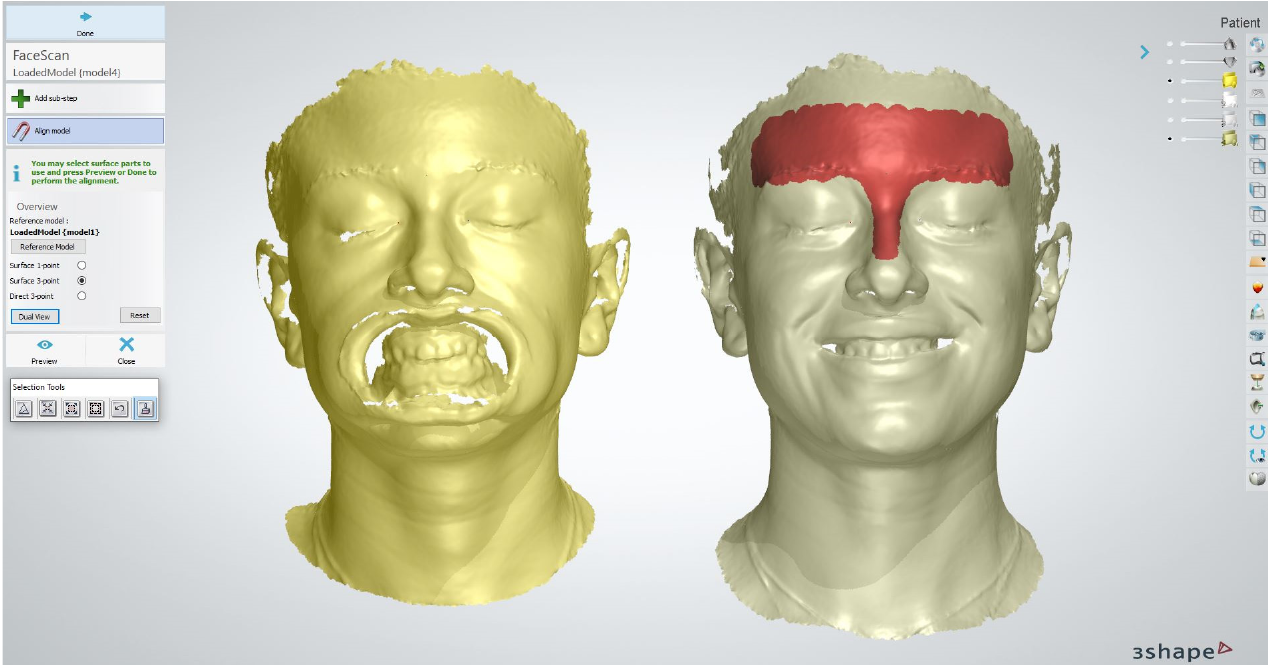
Figure 6. Matching the face scan with retractor with the face scan with closed mouth.